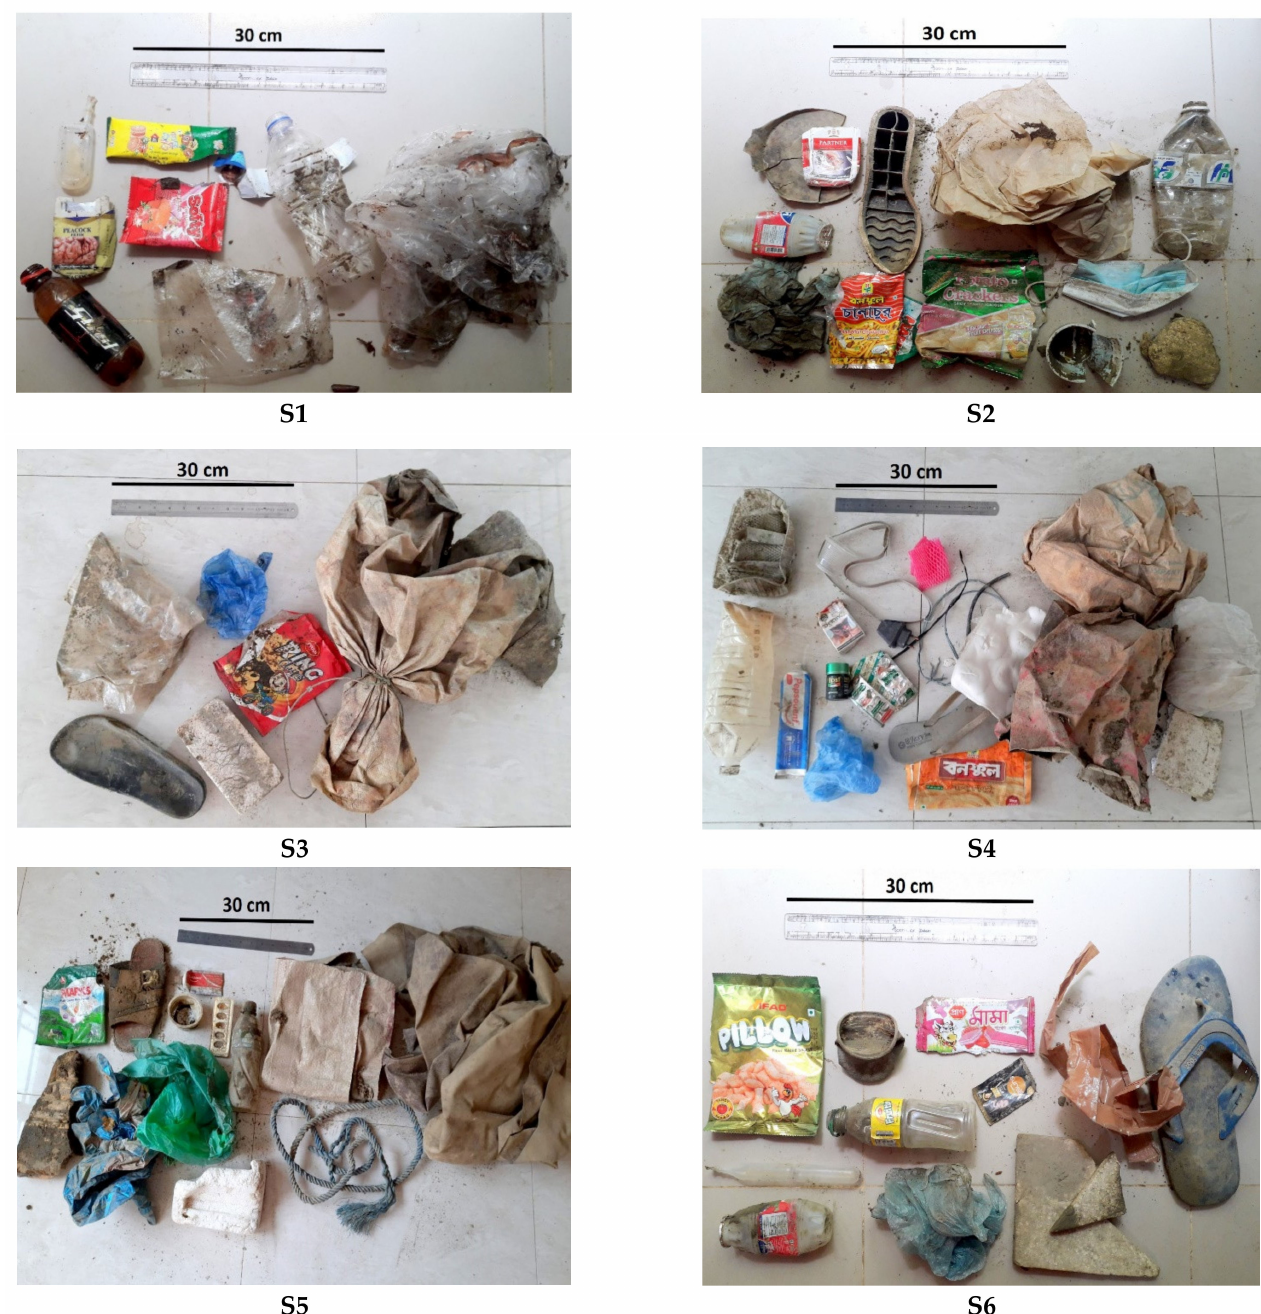
Figure 2. Different types of plastic items collected from different study areas ( S1 – S6